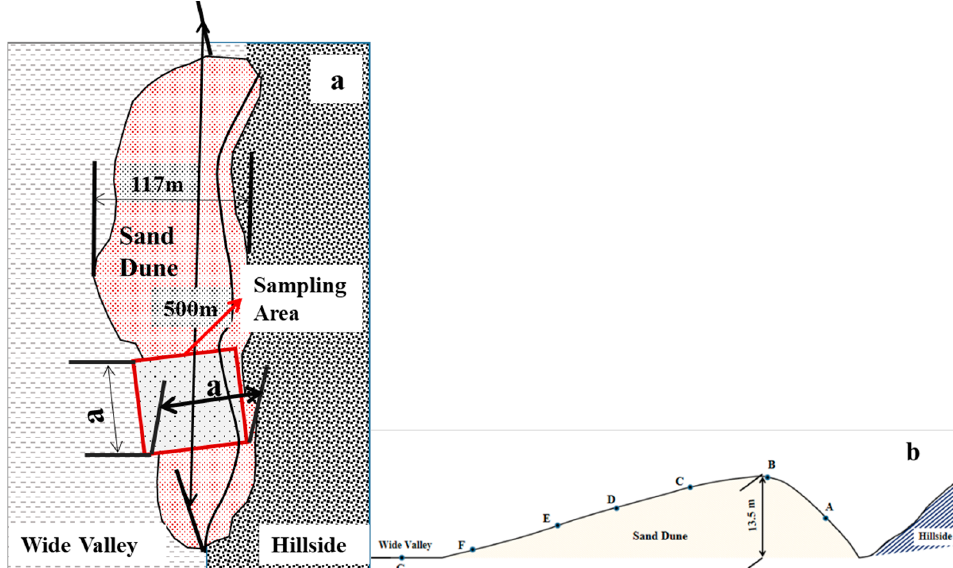
Figure 2. ( a ) Sketch of the planform of measuring positions on a sand dune (a = 100 m) and ( b ) sampling location of the dune: A is the middle part of the leeward slope, B is the top, C is the middle and upper part of the windward slope, D is the middle part of the windward slope, E is the middle and lower part of the windward slope, F is the bottom part of the windward slope, and G is the interdune land.